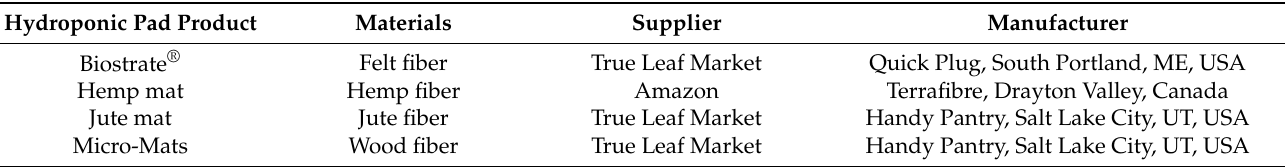
Table 2. Product name, constructed material, supplier, and manufacturer information of the four types of hydroponic pads used in this